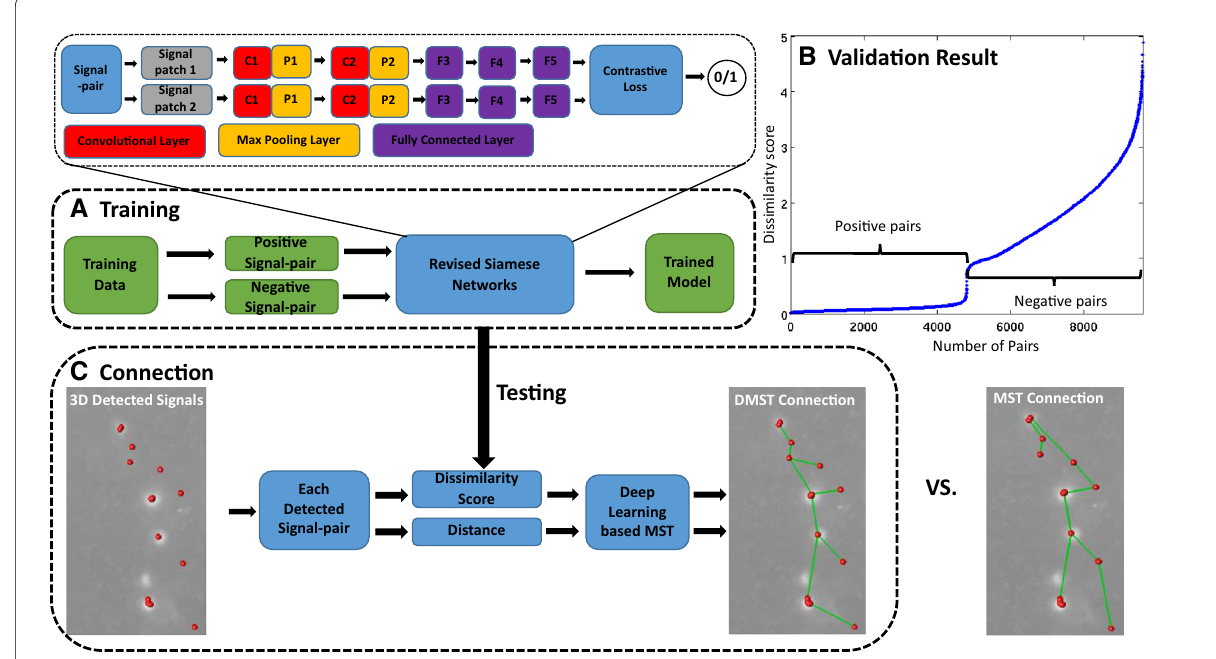
Fig. 4 The workflow of neurite connection module. ( a ) In the training step, the connectivity of a signal pair is learned using a revised Siamese network. In each pair, two 1 200 feature vectors are extracted. ( b ) The validated result with sorted dissimilarity scores for all signal pairs shows × that the dissimilarity scores of positive pairs are much lower than that of negative pairs. ( c ) The trained model is applied in the connection step to calculate the dissimilarity for each detected signal pair. Results of our DMST connection and the original MST connection (using distance as the weight only) are shown